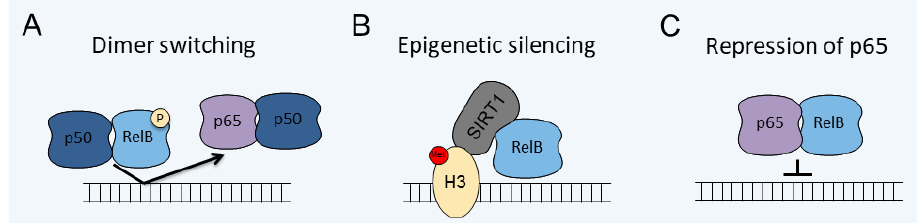
Figure 2. The mechanisms of RelB inhibition of p65/p50-mediated gene expression. ( A ) Dimer switching involves replacement of the p65/p50 complexes by the RelB/p50 complexes. ( B ) Epigenetic silencing involves recruitment of SIRT1, histone H3 deacetylation, and methylation. ( C ) Direct binding of p65 by RelB inhibits DNA binding. Histone H3, (H3); methyl, (Me); phosphate, (P); and Sirtuin 1, (SIRT1).